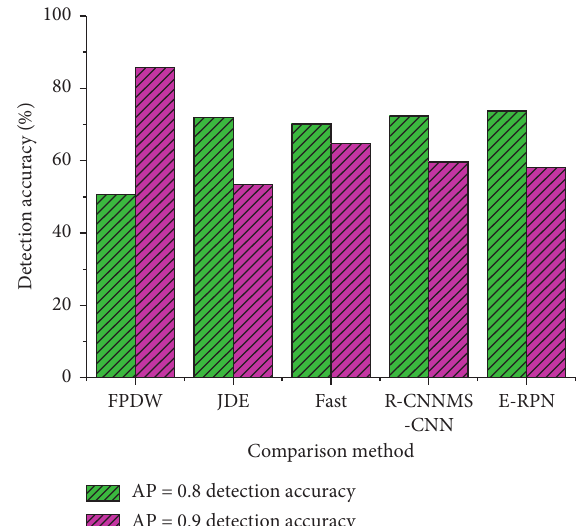
Figure 4: Experimental comparison of multiobjective tracking